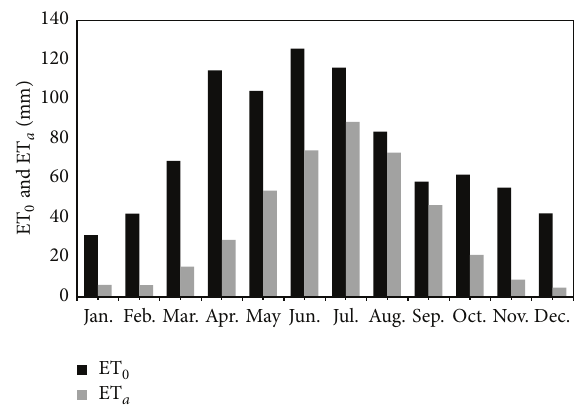
Figure 1: Annual variations in reference ET (ET 0 ) and actual ET (ET 𝑎